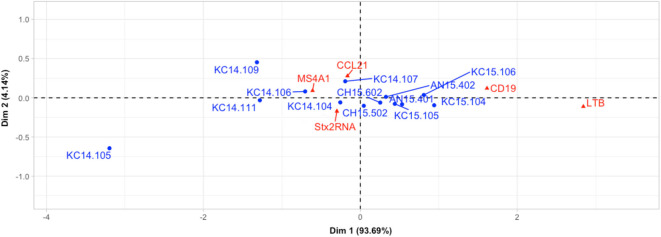
Assessment of associations between host immune gene expressions and Stx2+ samples using correspondence analysis. Red triangles and blue dots refer to host genes and Stx2+ samples, respectively. For example, “AN14.105” means the number of this sample is 105, breed is Angus, and was collected in 2014.